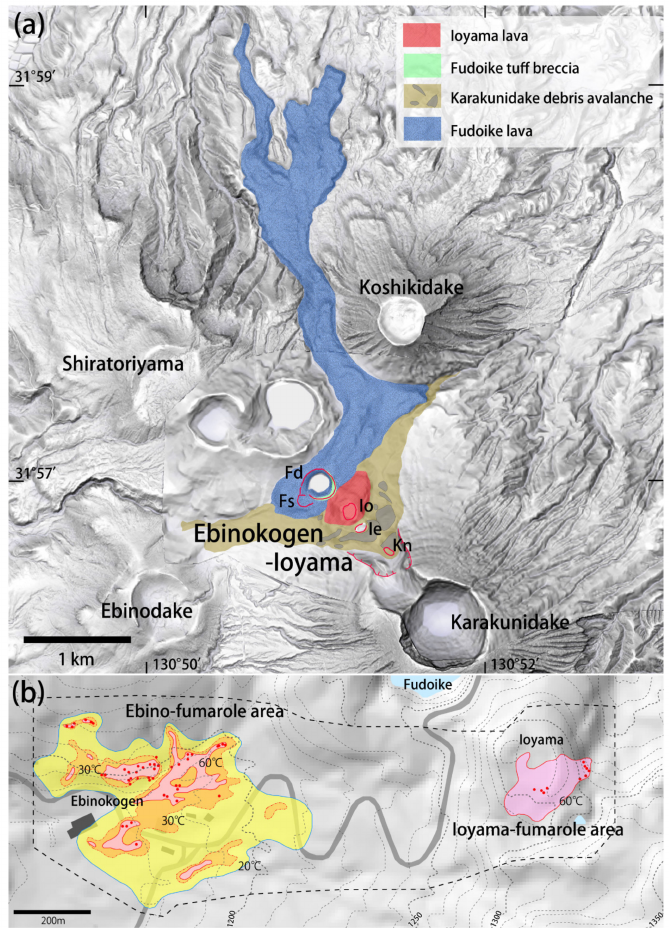
Figure 2. Shaded relief maps showing geological and geothermal features around Ebinokogen Ioyama Volcano. ( a ) Distribution of lavas and craters over 10,000 years [32]. Kn: Karakunidake north crater, Ie: Ioyama east crater, Io: Ioyama crater, Fd: Fudoike Crater, Fs: Fudoike south crater. Red circular lines denote the crater, red curves with ticks denote the amphitheater. The relief map using Kashimir3D [39]; ( b ) The distribution of Ebino-fumarole and Ioyama-fumarole areas in the 1950s [41]. Red points: active fumaroles. Numerals: the temperature of